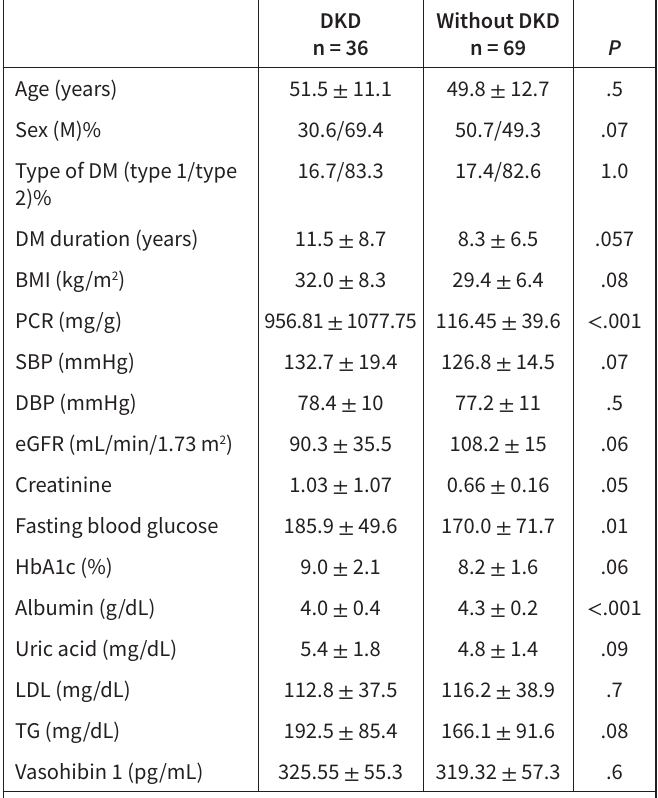
Table 2. Comparison of Diabetic Patients With and Without Kidney